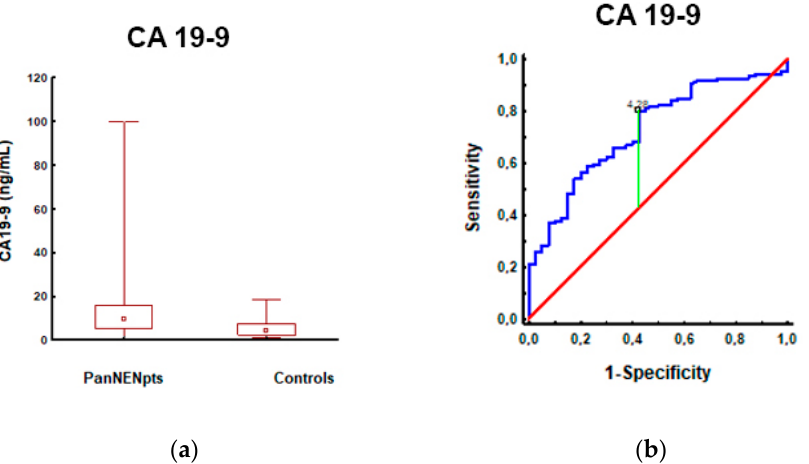
Figure 1. CA19-9 levels in patients with PanNEN and controls: ( a ) CA19-9 measurements were significantly higher in patients with PanNEN (12.89 ± 14.66; 9.43; n = 106) compared to controls (5.60 ± 4.46; 4.10; n = 63) ( p < 0.001); ( b ) The AUROC for CA19-9 levels in patients with PanNEN and controls: the AUROC (red line) for differentiating patients with PanNEN from controls was 0.73 (95%CI: 0.64–0.82; ( p < 0.001). A maximum AUC = 1 identifies an ideal (perfect) differentiation between disease and non-disease subjects. The diagonal line (AUC = 0.5) corresponds to chance discrimination. The CA19-9 AUC > 0.7 (red line) indicates that it is a fair biomarker for patients with PanNEN.